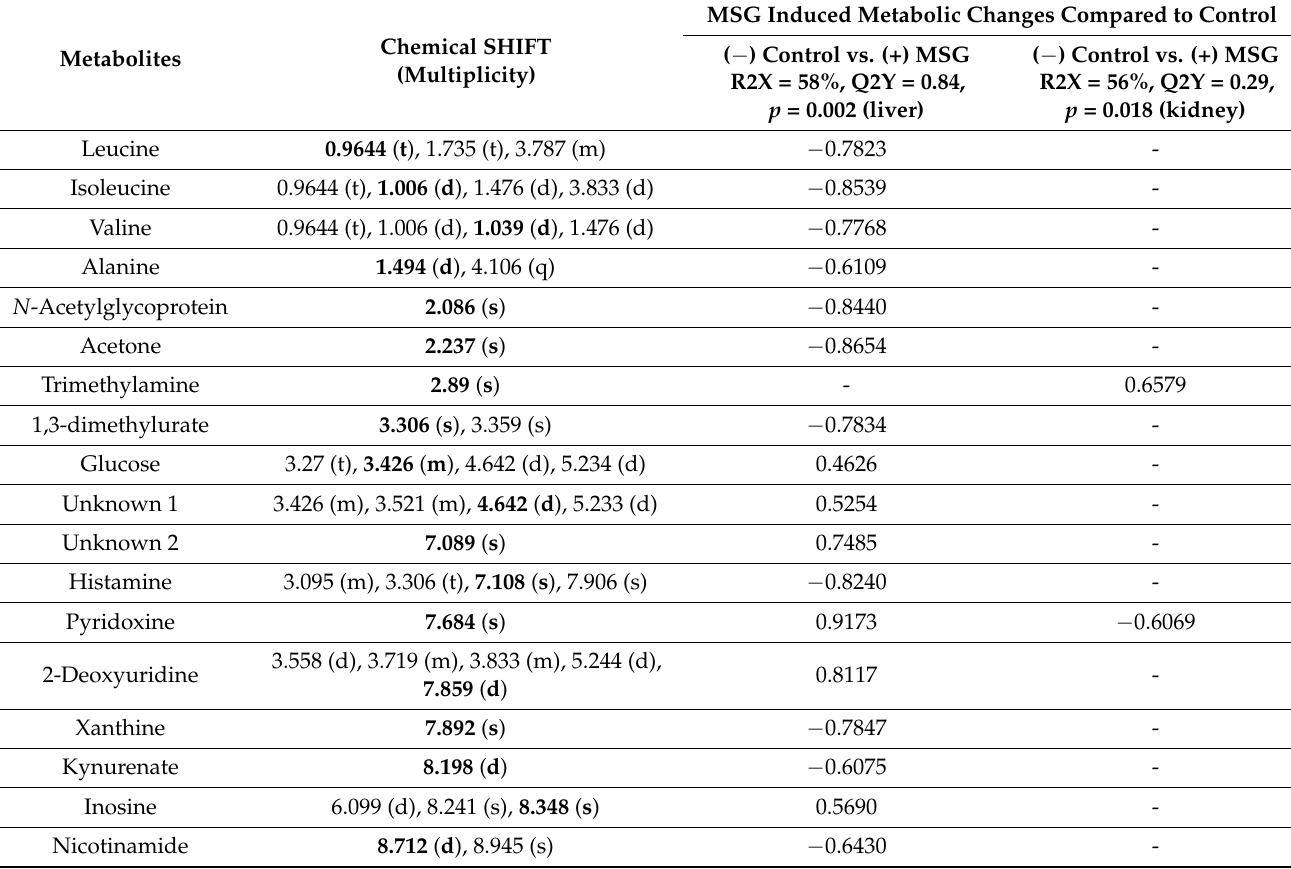
Table 1. Relative changes in liver and kidney metabolites of control and MSG-treated rats, using the 1 H NMR profiles.